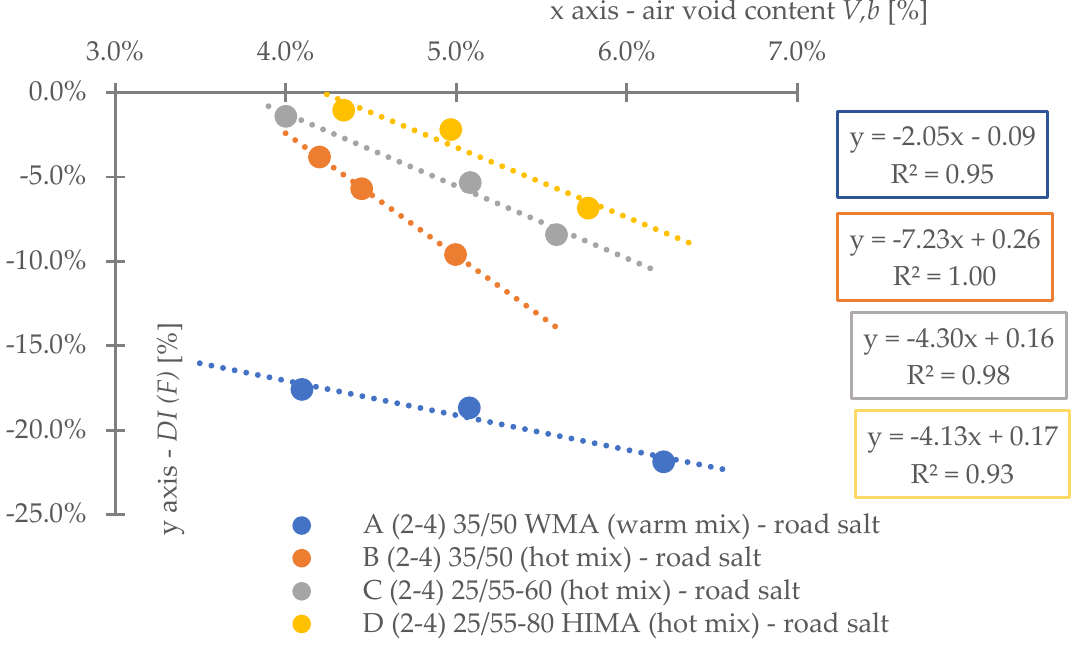
Figure 14. Road salt fatigue degradation considering air void content variability.